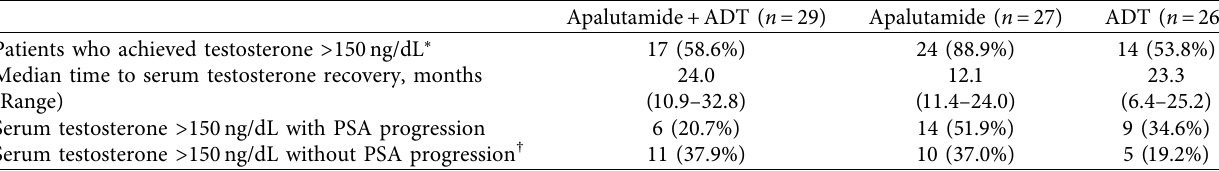
Table 4: Summary of serum testosterone recovery ( T > 150ng/dL) at 24 months with or without PSA progression.